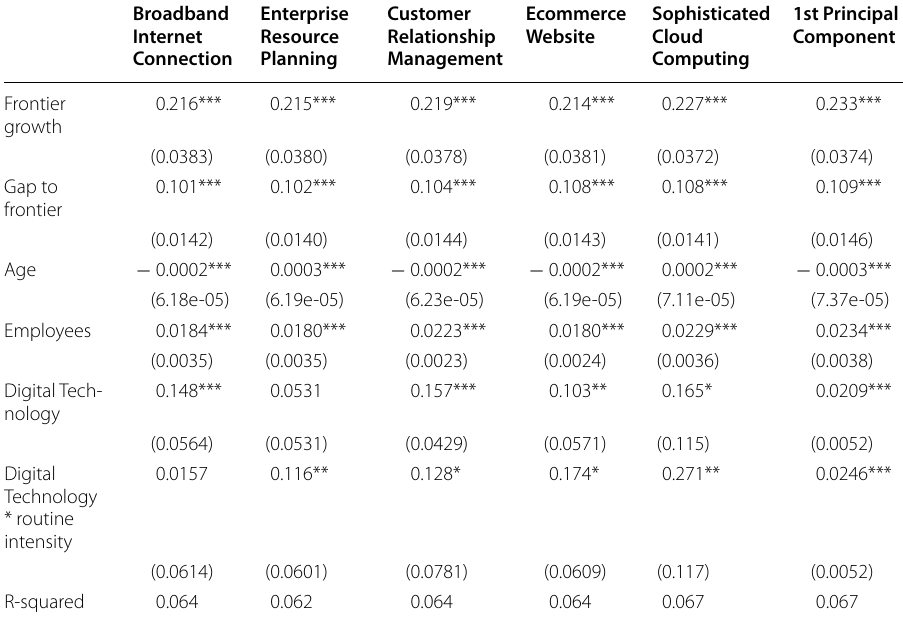
***, ** and * correspond to p < 0.01, p < 0.05 and p < 0.1 respectively. The last column shows results for the 1st principal component of the five technological